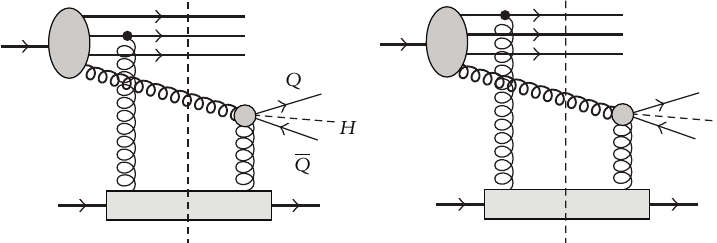
Figure 15: Dominant gluon-initiated contributions to the single diffractive 𝑄𝑄 + 𝐻 production